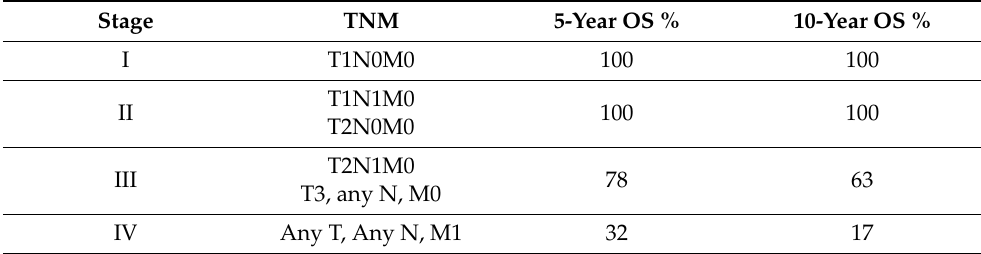
Table 1. Appendiceal Neuroendocrine Tumors-specific survival rates [68,74,81]. Stage